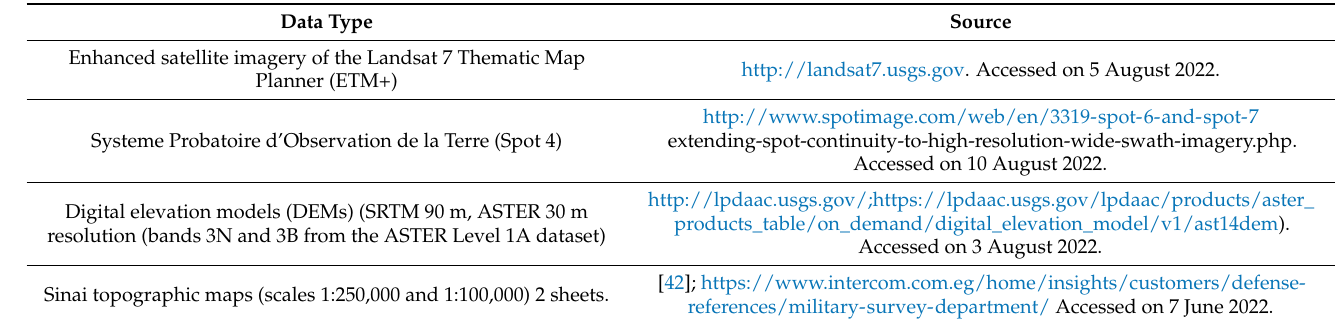
Table 1. Data types and